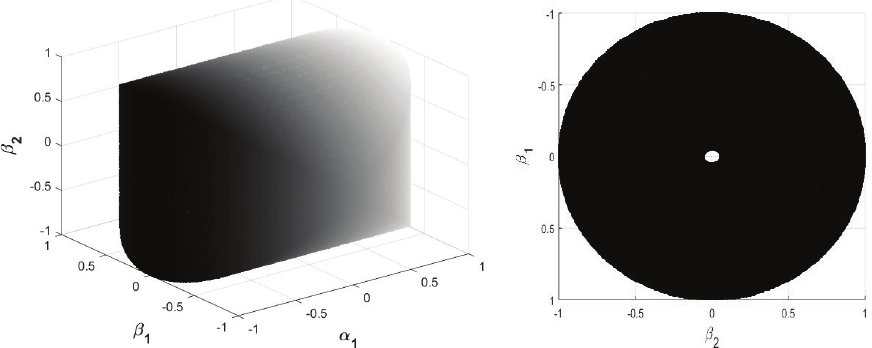
Figure A3. The left image shows a typical 3 D submanifold of the ˘ C family that has a topology. The right figure shows the projection of this submanifold on the plane ( α 1 , β 1 ) . Recall that the projections of the submanifold on the plane ( β 1 , β 2 ) and ( α 1 , β 2 ) do not contain topologies.